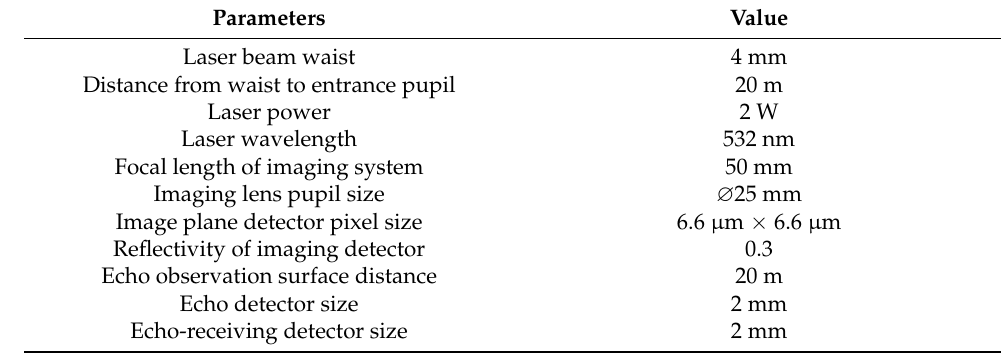
Figure 3. Comparison of imaging quality between conventional imaging system and wavefront coding imaging system under different defocus amounts. ( a ) original image; ( b ) intermediate coded image obtained by conventional imaging system under a defocus amount of 10 units; ( c ) decoded image from conventional imaging system; ( d ) intermediate coded image obtained by wavefront coding system under a defocus amount of 10 units; ( e ) decoded image from wavefront coding system. Table 1. The simulation parameters of cat-eye